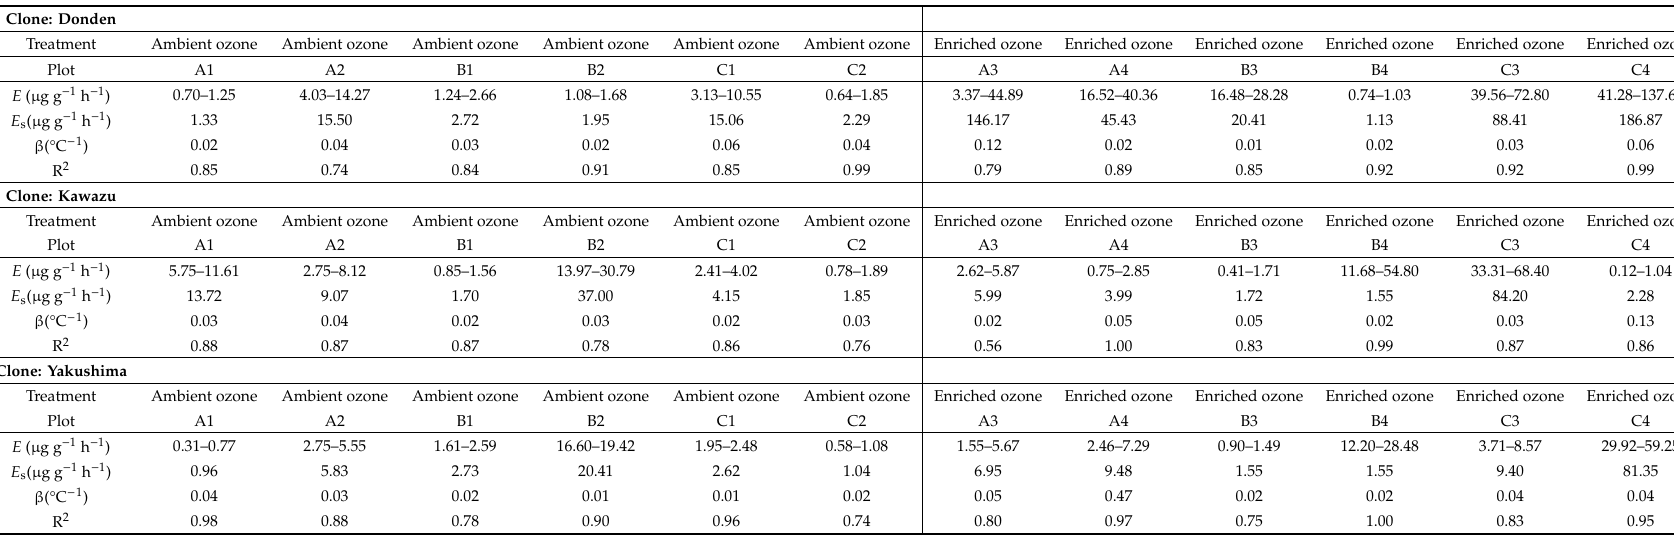
Table 1. Summary of the emission rates of total monoterpenes in January (winter). The six plots (A1–C2) on the left side are control plots with the ambient ozone concentration, whereas the remaining plots (A3–C4) on the right side are plots with an elevated ozone concentration that was twice that of the control plots. Clone: